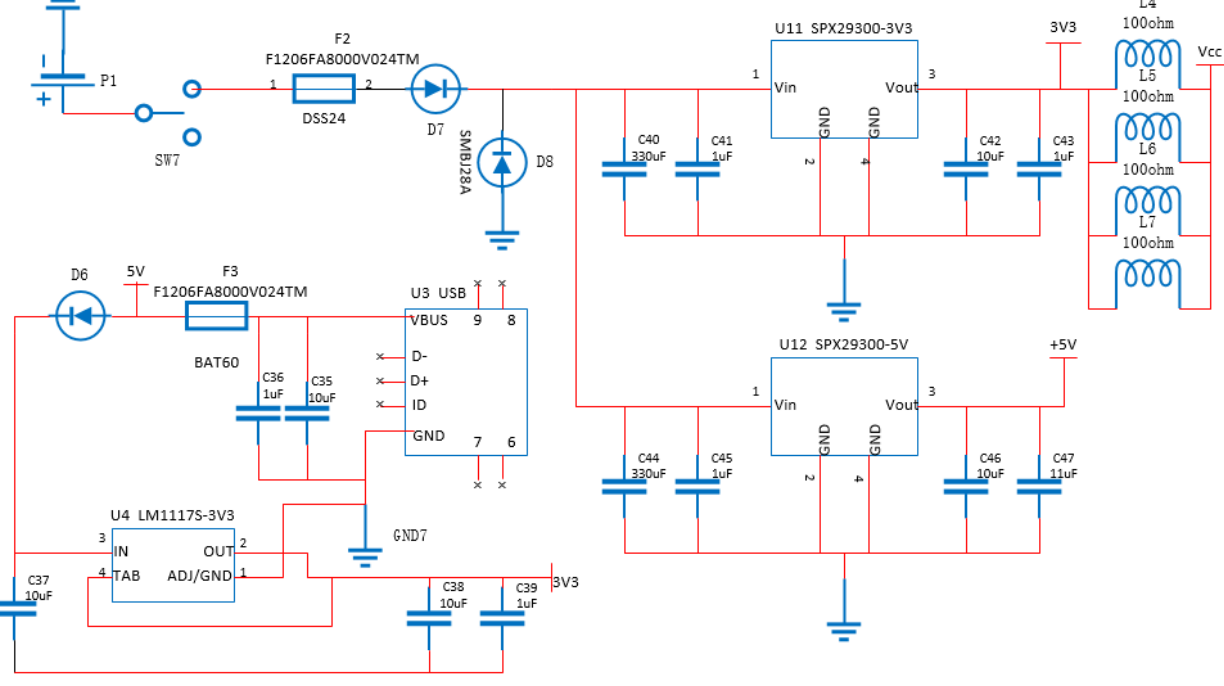
Figure 8. Power supply circuit design.